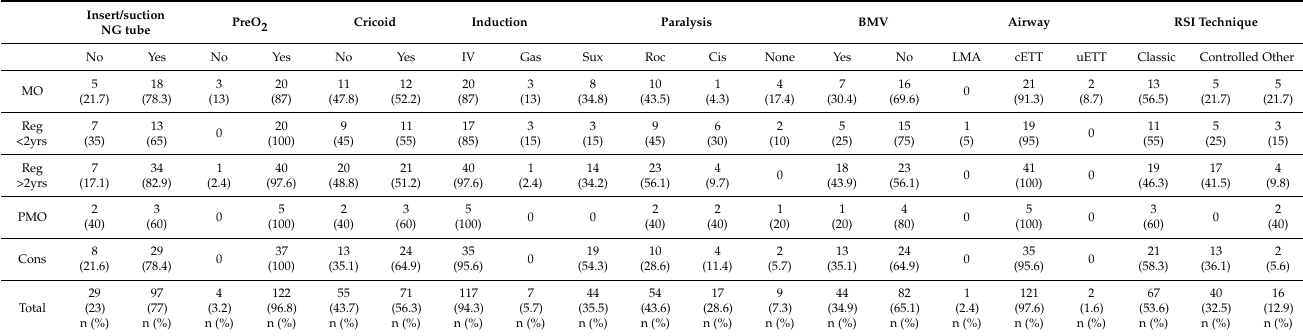
Table 3. Anaesthesia Technique for Laparotomy for Suspected Small Bowel